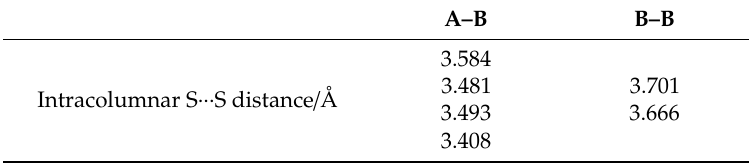
Figure 1. Crystal structure of TTF-py 2 _PF 6 . ( a ) Thermal ellipsoid plot of TTF-py 2 _PF 6 . Counteranion (PF 6– ) and crystal solvent (EtOH) were pictured in capped sticks, and hydrogen atoms are omitted for clarity. ( b , c ) π -stacked TTF-py 2 columns viewed from di ff erent sides. Blue broken lines are written to represent the shift of π -stacks. Counteranion and crystal solvent were omitted for clarity in ( c ). ( d , e ) Perspective views of TTF-py 2 _PF 6 along the a axis with placing A or B at the center, respectively. Short contacts with neighboring columns are represented as broken orange lines. ( f , g ) View of the angle of the hydrogen bonding site between A and B ( f ) and B and B ( g ). Hydrogen atoms of pyridyl groups were omitted for clarity. Yellow, S; Orange, P; Light green, F; Red, O; Blue, N; Gray, C; White, H. Table 1. The distances between the nearest sulfur atoms along the π -stack